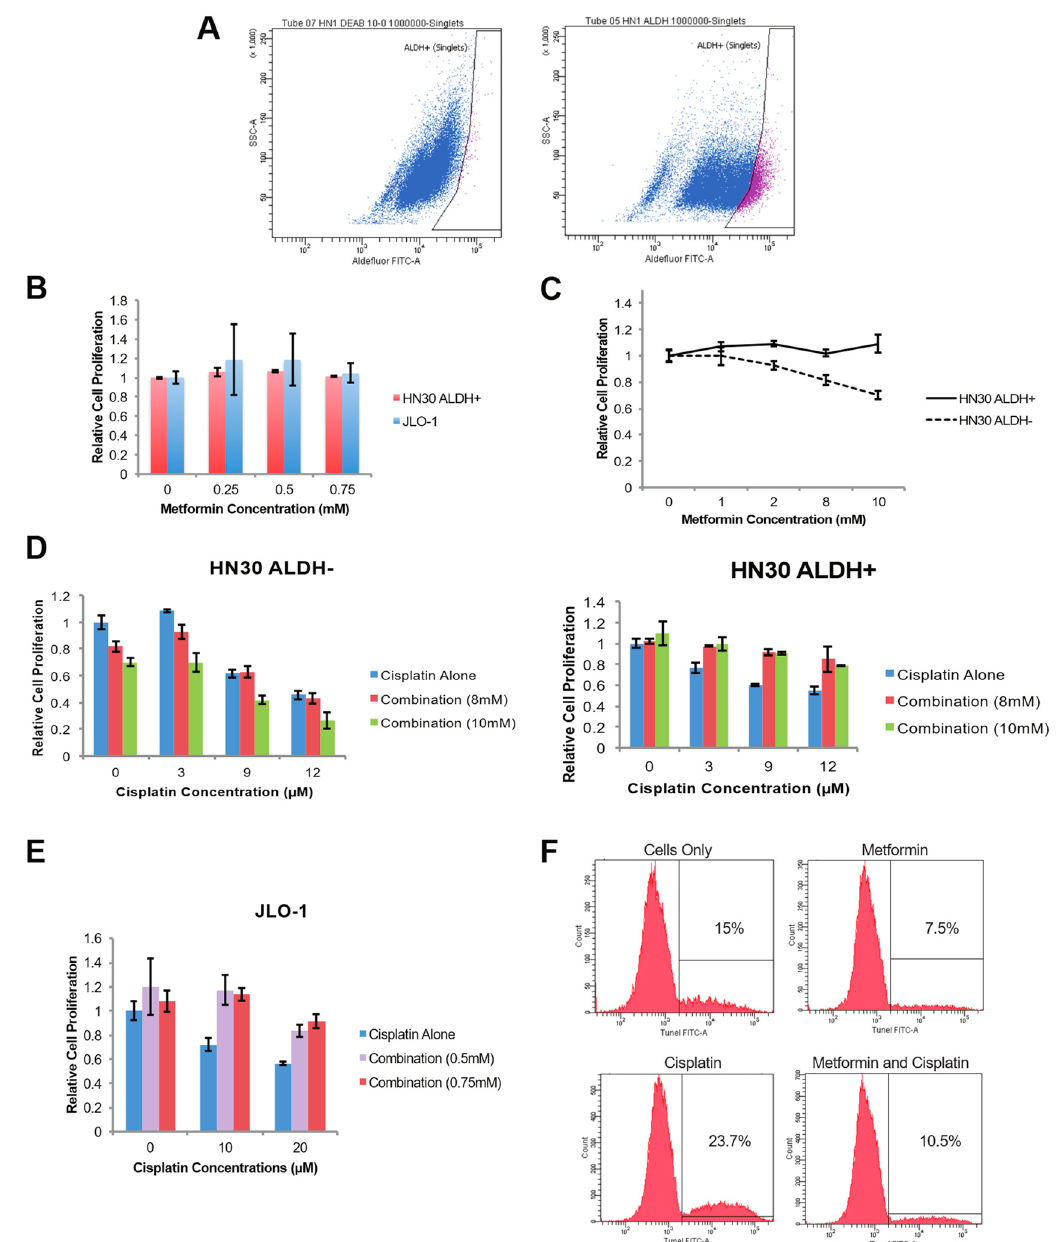
Figure 1. Metformin’s effects on head and neck squamous cell carcinoma (HNSCC) cancer stem cells (CSCs) and non-stem HNSCC cells. ( A ). Flow cytometry sorting of ALDH − and ALDH+ cells from the HN-30 cell line. ( B ). Cell proliferation levels of ALDH+ HN-30 cells and JLO-1 cells were measured through the MTS assay at 4 different concentrations of metformin applied. ( C ). Cell proliferation levels of ALDH+ HN-30 cells were compared against that of ALDH − HN-30 cells after application of metformin in various concentrations. ( D ). Cell proliferation levels of ALDH+ and ALDH − HN-30 cells after co-treatment of metformin and cisplatin. ( E ). Cell proliferation levels of JLO-1 cells after co-treatment of metformin and cisplatin. ( F ). TUNEL assay plots showing percentage of JLO-1 cells with DNA double strand breaks.